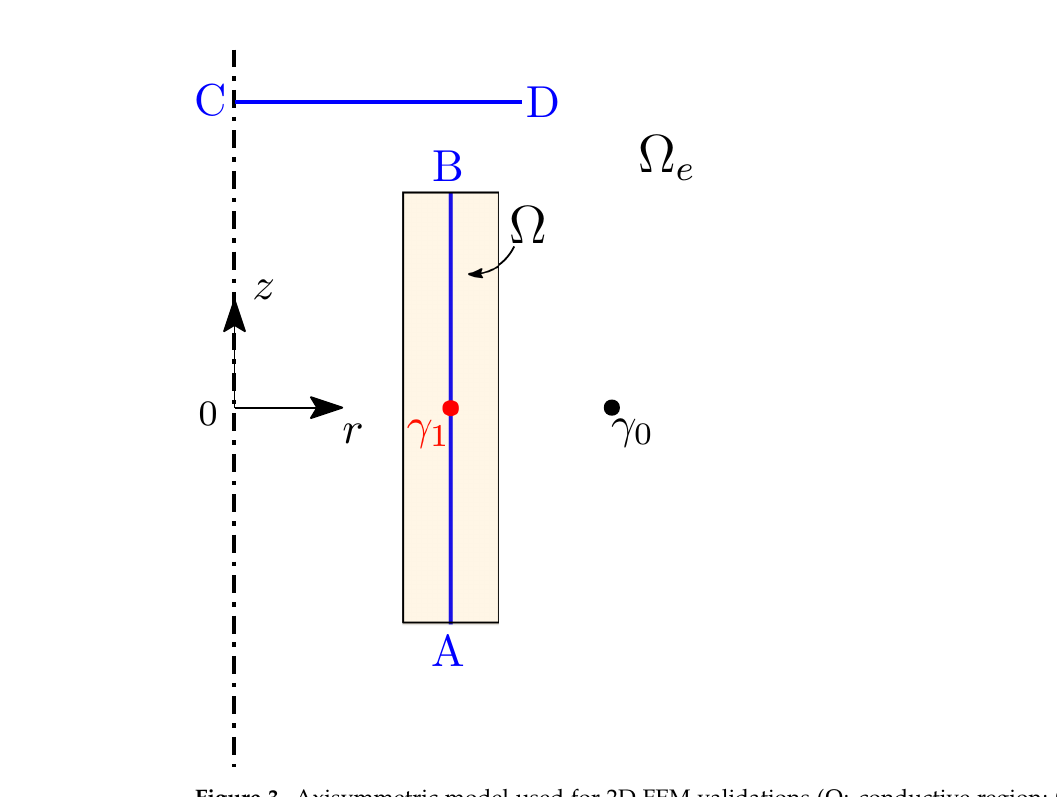
Figure 3. Axisymmetric model used for 2D FEM validations ( Ω : conductive region; Ω e : exterior domain; γ 0 : source coil; γ 1 : virtual coil; line A-B is used for the current density evaluation in the shell region; line C-D is used for the magnetic flux density evaluation in the air region).